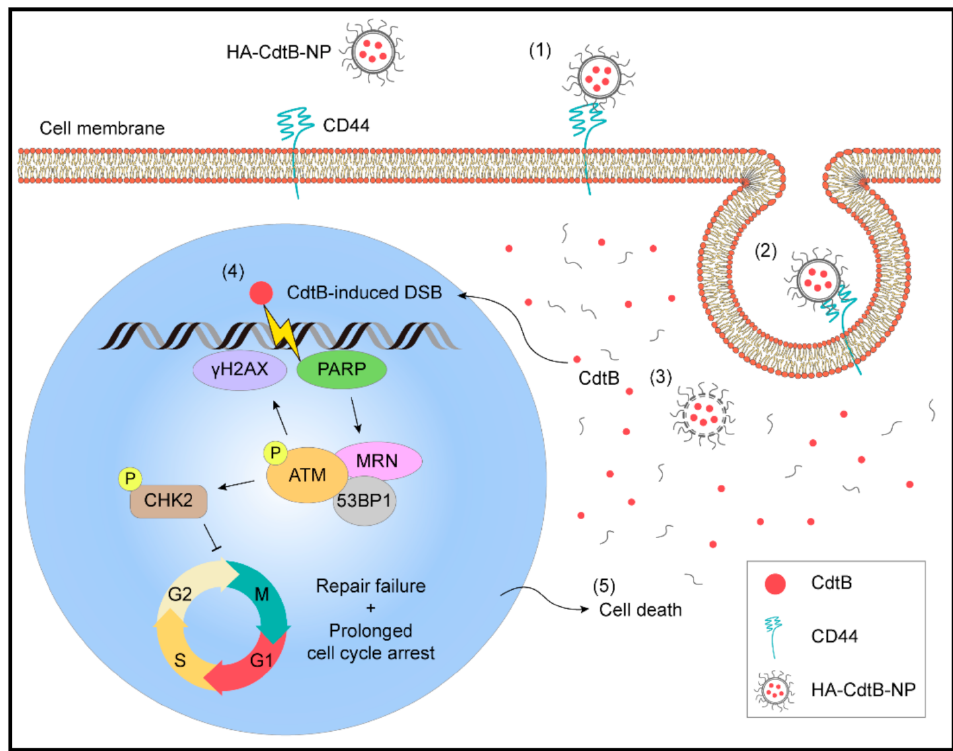
Figure 7. The effects of HA-CdtB-NPs on radioresistant PCa cells. (1) HA-based nanoparticles specifically bind to CD44 on the cell membrane and (2) the encapsulated CdtB is delivered into PCa cells through endocytosis. (3) With nuclear translocation signal (NLS), CdtB enters the nucleus and (4) exerts its DNase activity to effectively induce DSBs, leading to cell cycle arrest. (5) As the cancer cells fail to repair the extensive DNA damage and experience prolonged cell cycle arrest, they are sentenced to death. This study unveils the mechanism behind the radiosensitivity enhancement in PCa cells promoted by HA-CdtB-NPs and thus provides a promising target-specific agent for the development of a new therapy against radioresistant PCa.